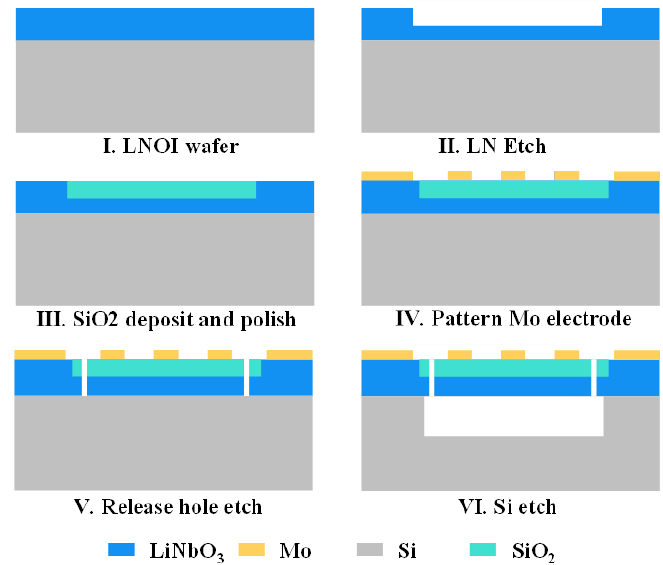
Figure 6. The fabrication process flow for the proposed devices.